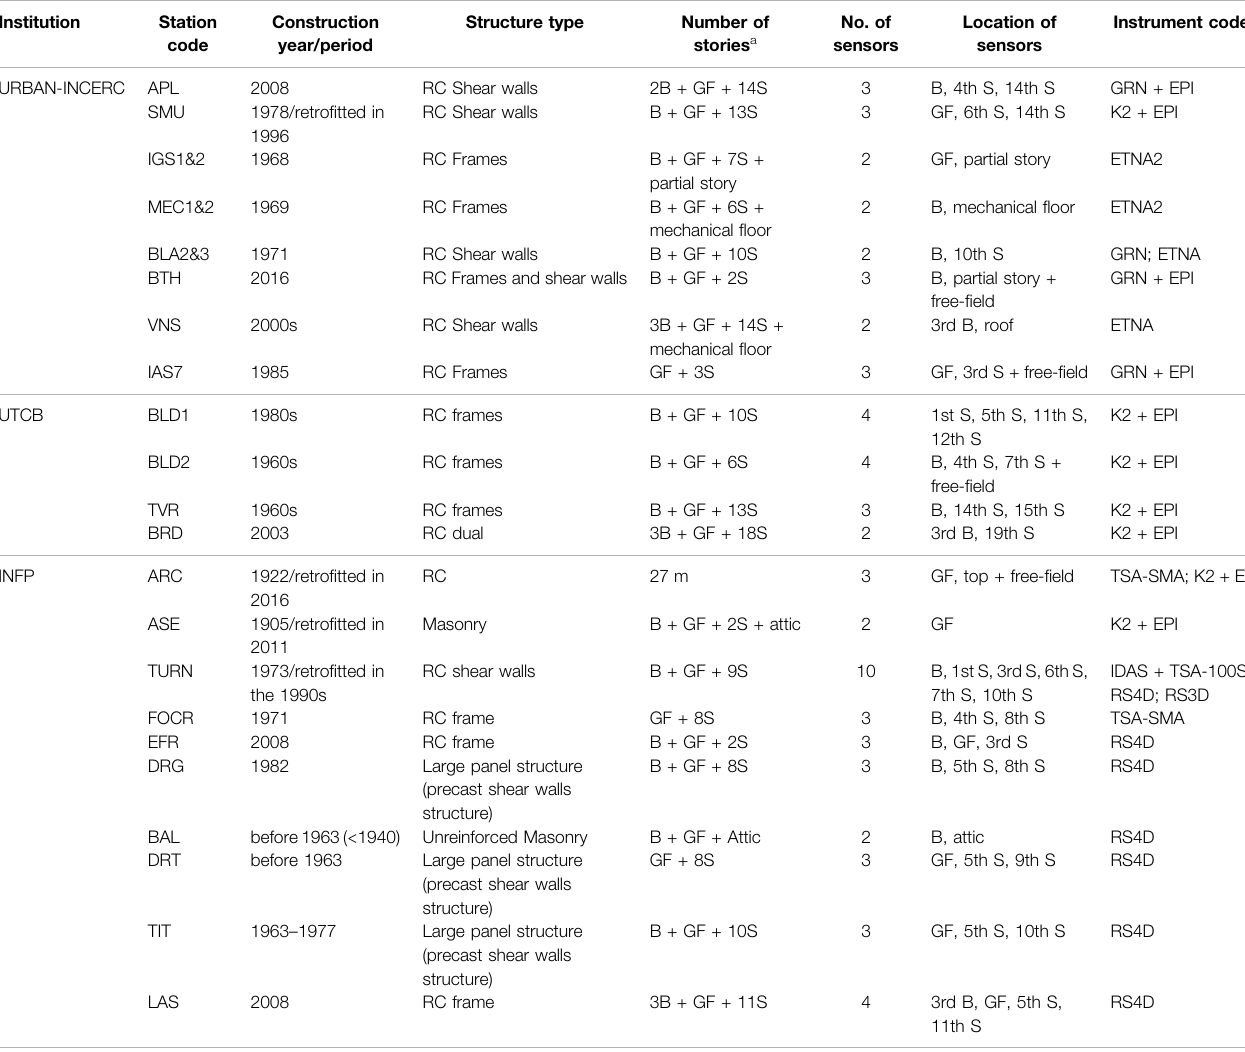
TABLE 1 | Characteristics of the instrumented structures.